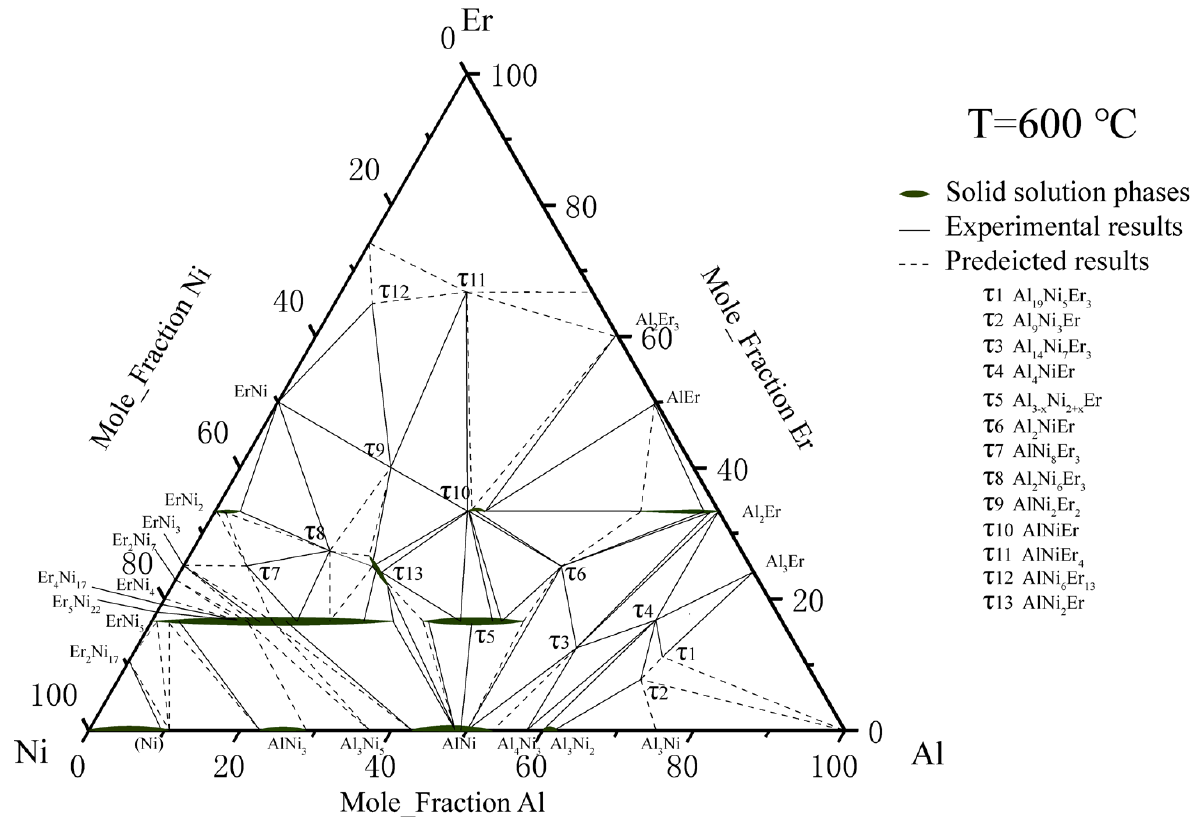
Figure 5. Al–Ni–Er phase diagram assessed by Zhao et al. [34].